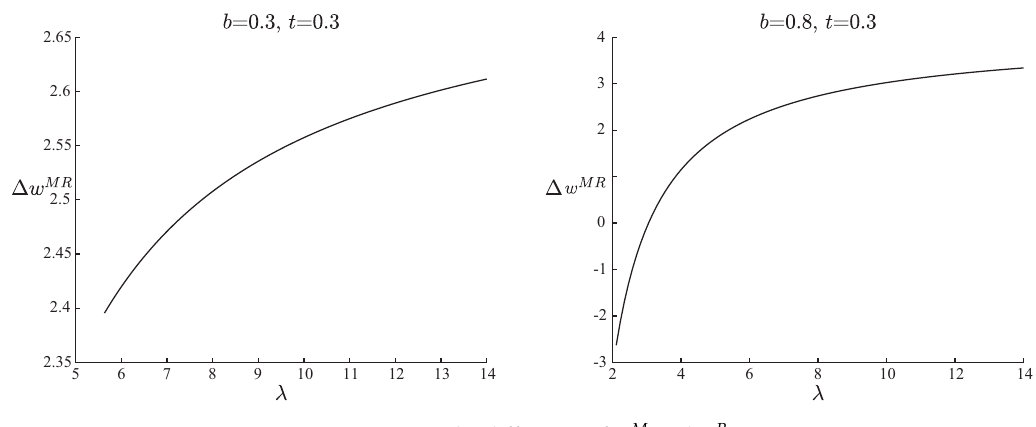
Figure 1. The difference of w M